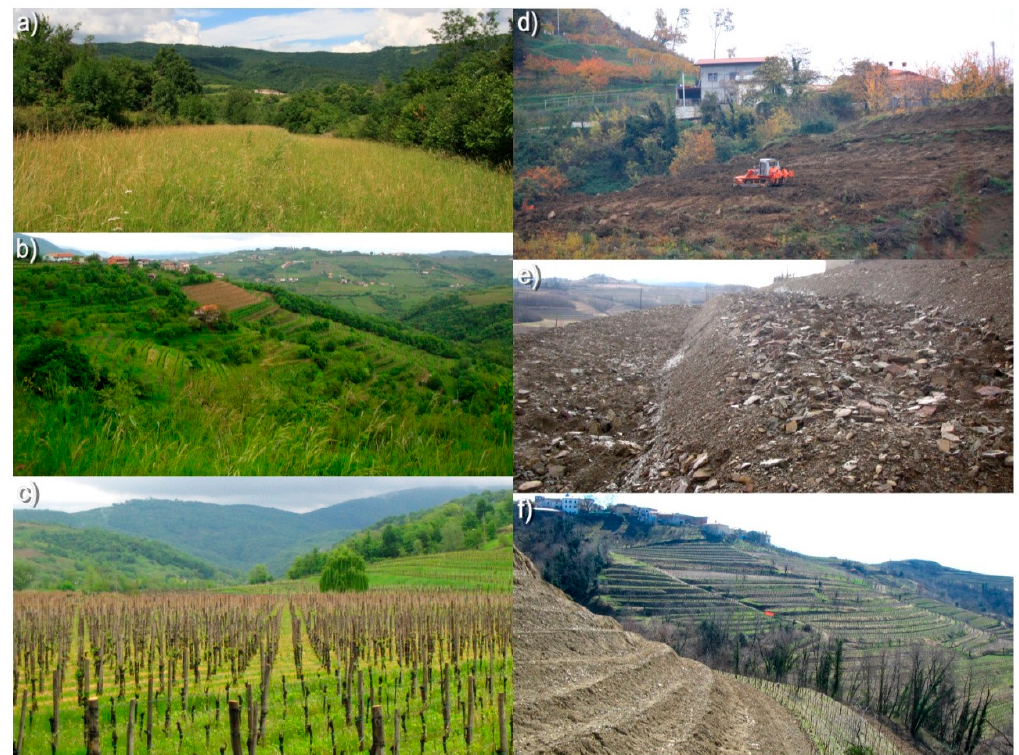
Figure 2. The study area of the Kožbanjšˇcek stream catchment in Goriška Brda, Slovenia. ( a ) Korada Hill, ( b ) cultivation terraces in Goriška Brda, ( c ) view towards the forested part of the catchment from the bottom of the valley, ( d – f ) earthworks to establish cultivation terraces for vineyards on flysch geology.